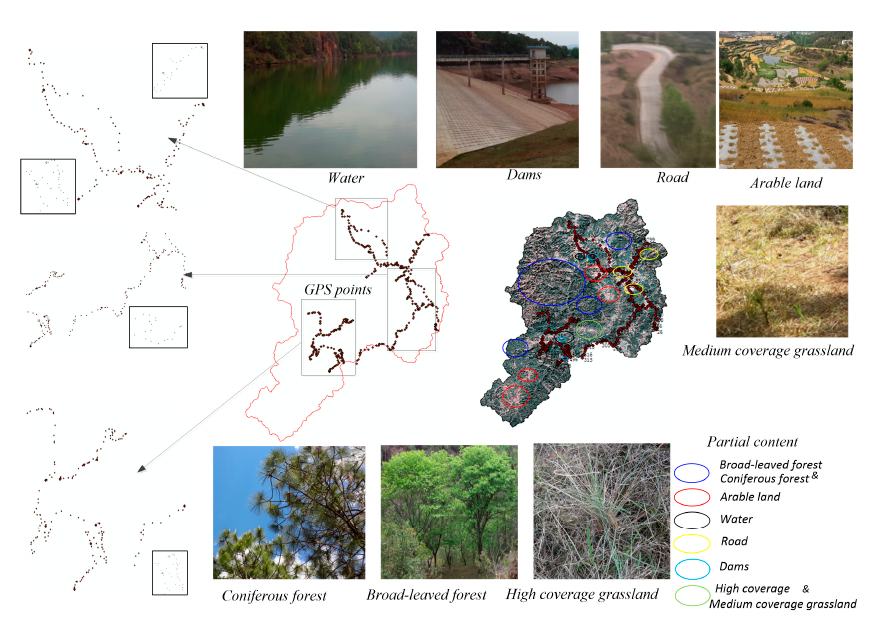
Figure 4. GPS points for LULC analysis in the study area. Table 5. Precision index of LULC classification.